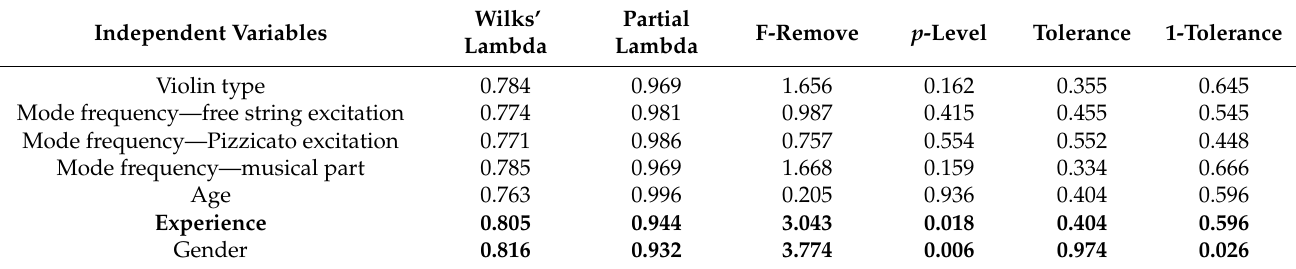
Table 5. The results of the multifactor discriminant analysis regarding bright